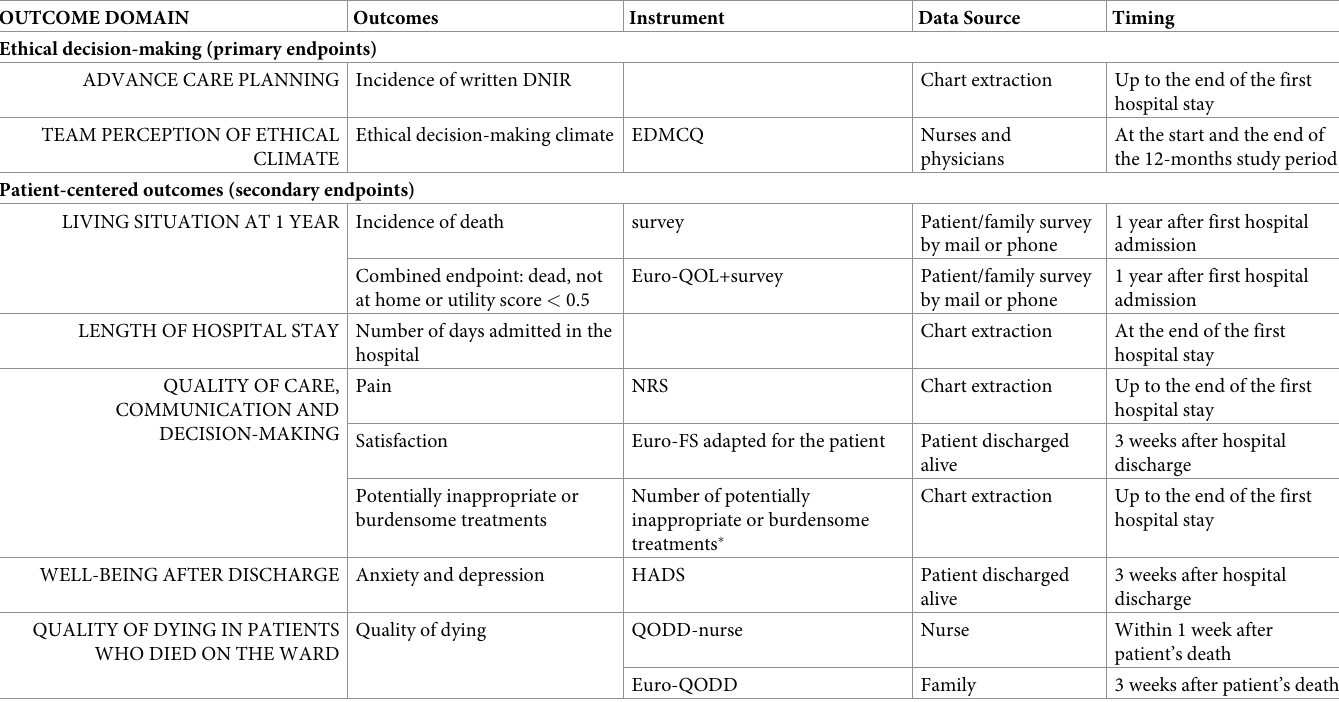
Table 2. Overview of collected data and timelines: Primary outcomes and secondary outcomes on patient